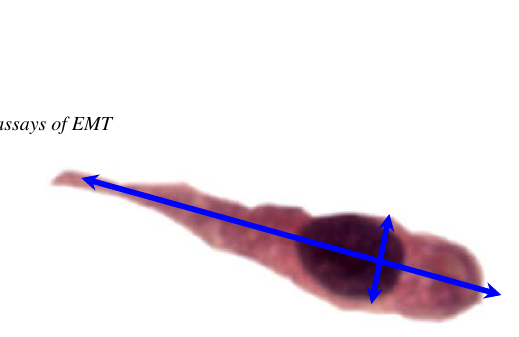
Fig. 1. Spindle Index. KS400 software was used to derive the Spindle Index which was the ratio of maximum length to the maximum width (measured normal to the length axis) of each cell. (The colors are visible in the online version of the article.)